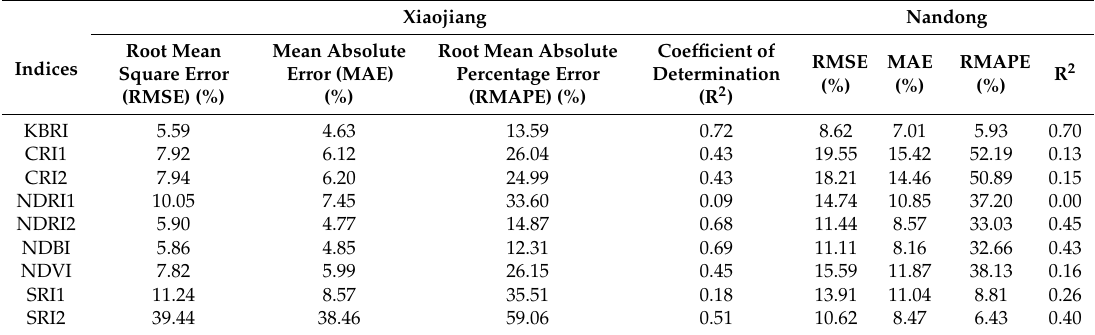
Table 2. Accuracy assessment of the linear regression models in the Xiaojiang and Nandong watershed.